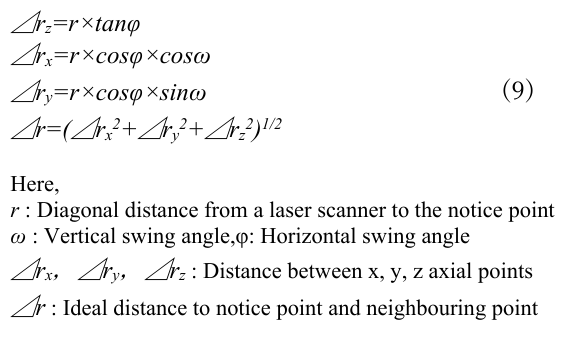
⊿ r : Ideal distance to notice point and neighbouring point We computed the radius of circles for groups of points